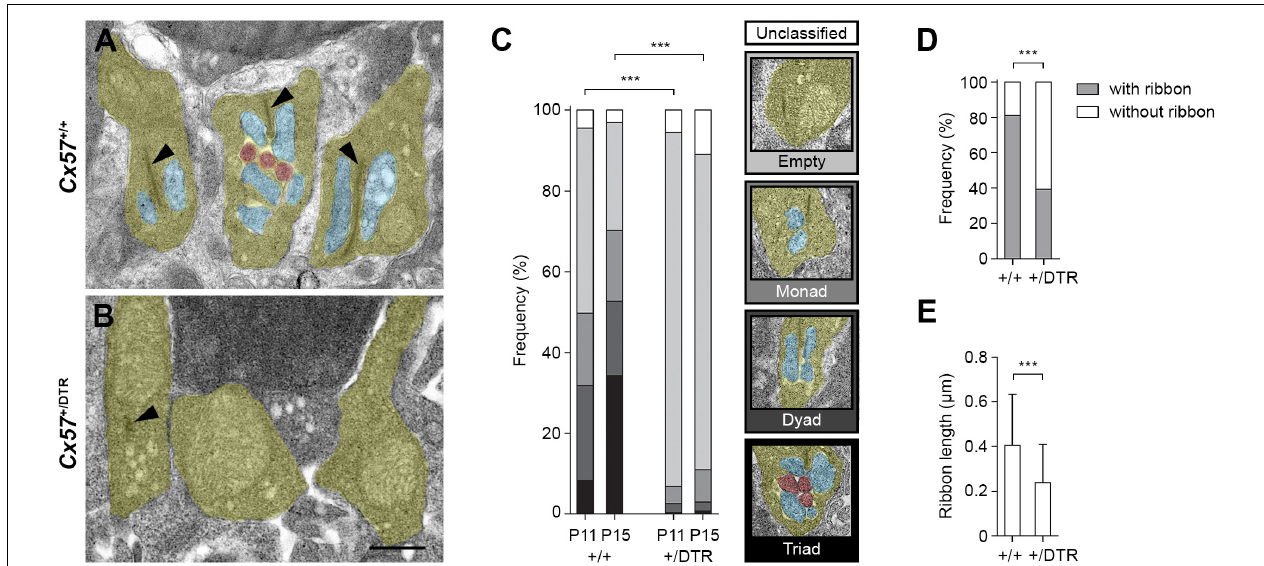
FIGURE 2 | Rod terminals of horizontal cell-ablated mice lack ON bipolar cell invaginations. (A,B) Representative electron micrographs of rod terminals from Cx57 + / + and Cx57 + / DTR mice at P15. Rod terminal profiles (yellow) in wild-type retinae showed large presynaptic ribbons (arrowheads) and invaginations from horizontal cells (blue) and ON bipolar cells (red) (A) . In contrast, rod terminal profiles in horizontal cell-ablated retinae typically lacked any invaginations. Synaptic ribbons were absent or shorter (arrowhead) (B) . (C) Quantification of rod synaptogenesis stages in Cx57 + / + and Cx57 + / DTR mice at P11 and P15. Between 746 and 1177 rod terminal profiles from wild-type ( n = 4 for P11 and n = 3 for P15) and Cx57 + / DTR mice ( n = 4 for P11, n = 5 for P15) were analyzed for each age. Rod terminal profiles without invaginations were designated as empty, rod terminal profiles with one or two horizontal cell process were designated as monads or dyads, respectively, and rod terminal profiles containing at least one invaginating ON bipolar cell dendrite were designated as triads. p < 0.0001, χ 2 test. (D) Frequencies of rod terminal profiles with and without ribbons in wild-type ( n = 3) and horizontal cell-ablated ( n = 5) retinae. p < 0.0001, Fisher’s exact test. (E) Quantification of ribbon lengths in Cx57 + / + (n = 3) and Cx57 + / DTR ( n = 5) mice. p < 0.0001, Wilcoxon rank rum test. Values are presented as mean ± SD. ∗∗∗ p < 0.001. Scale bar, 500 µ